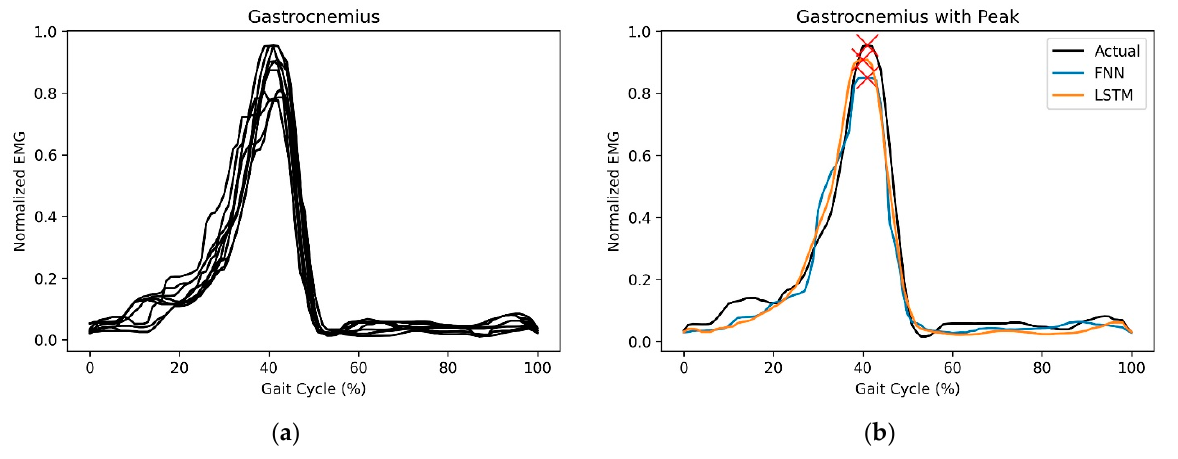
Figure 1. ( a ) The normalized EMG data of glutes medius in several gait cycles; ( b )The peak muscle contraction of actual and predicted EMG of gastrocnemius in one gait cycle. contraction of actual and predicted EMG of gastrocnemius in one gait